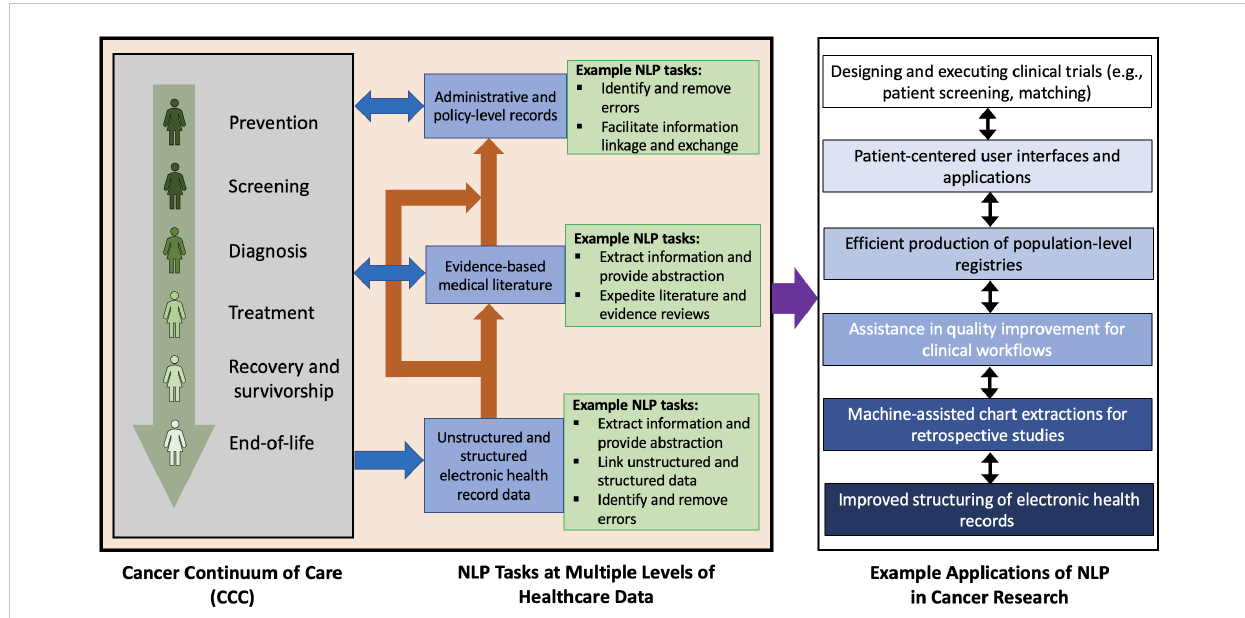
FIGURE 1 Potential NLP tasks at various levels of electronic healthcare data and some corresponding applications of NLP in oncology. The stages of the cancer continuum of care are as indicated by Cancer Care Ontario (7). The example applications listed may overlap or have mutual in fl uence on each